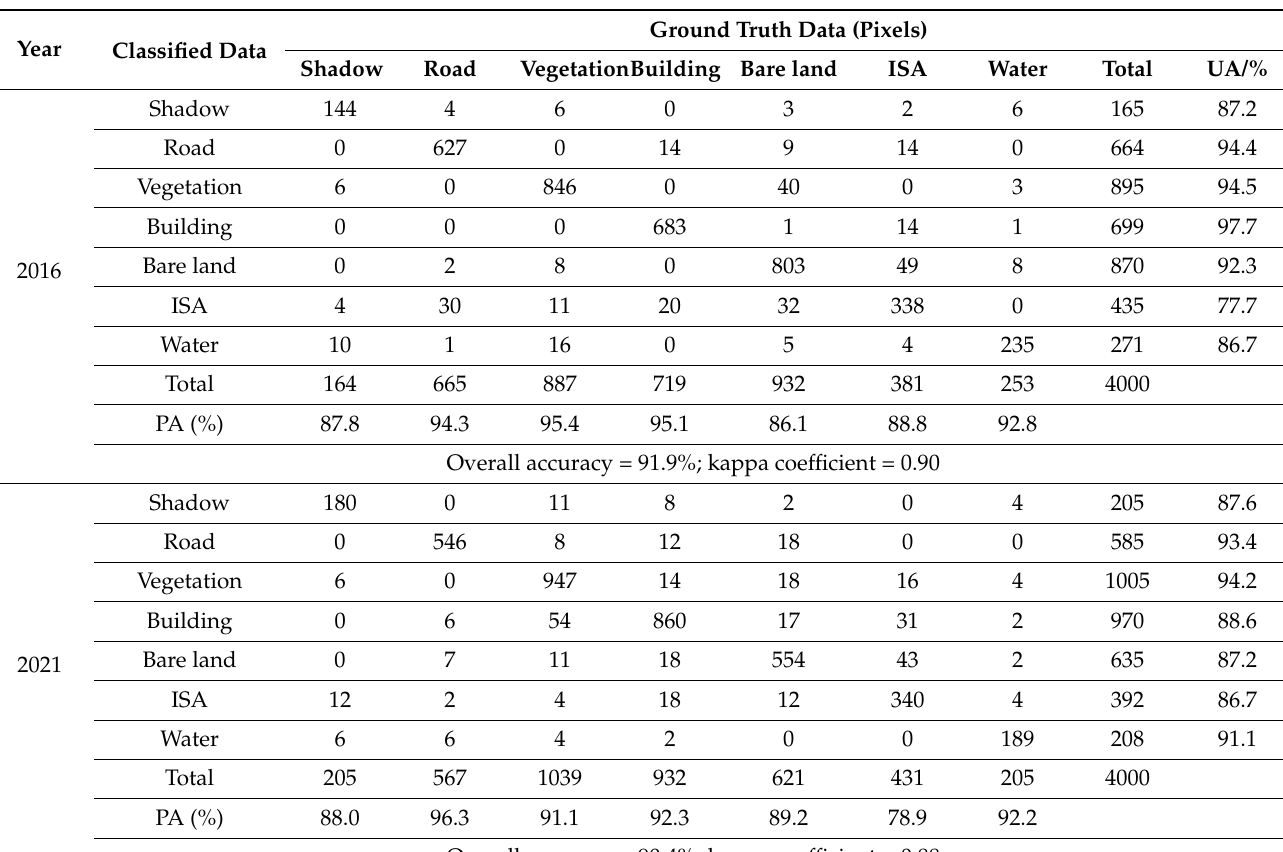
Table 5. Confusion matrix for Beijing land-cover mapping in 2016 and 2021 (UA—user’s accuracy; PA—producer’s accuracy).